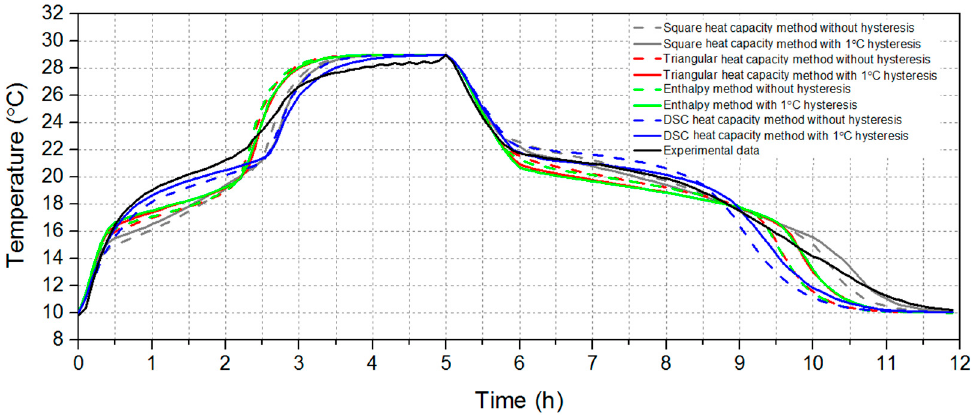
Figure 3. The temperature of PCM at a height of 510 mm in the heat exchanger as a function of time.